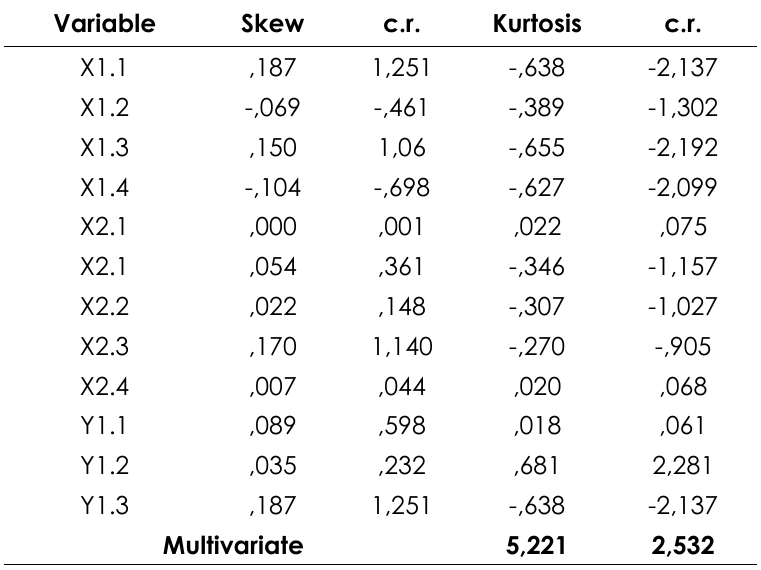
Testing of Data